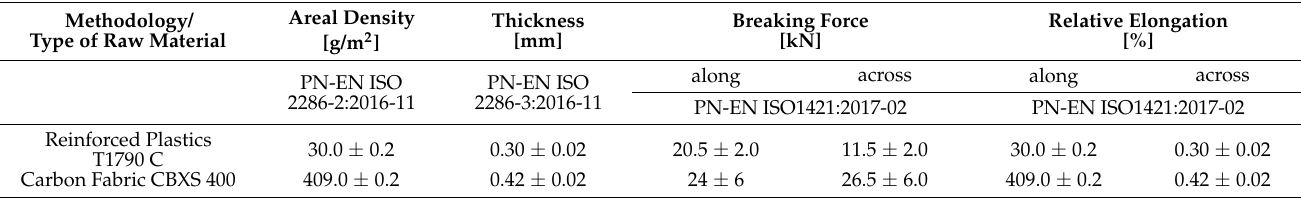
Table 2. Main properties of nonwovens for Fiber Reinforced Plastics T1790